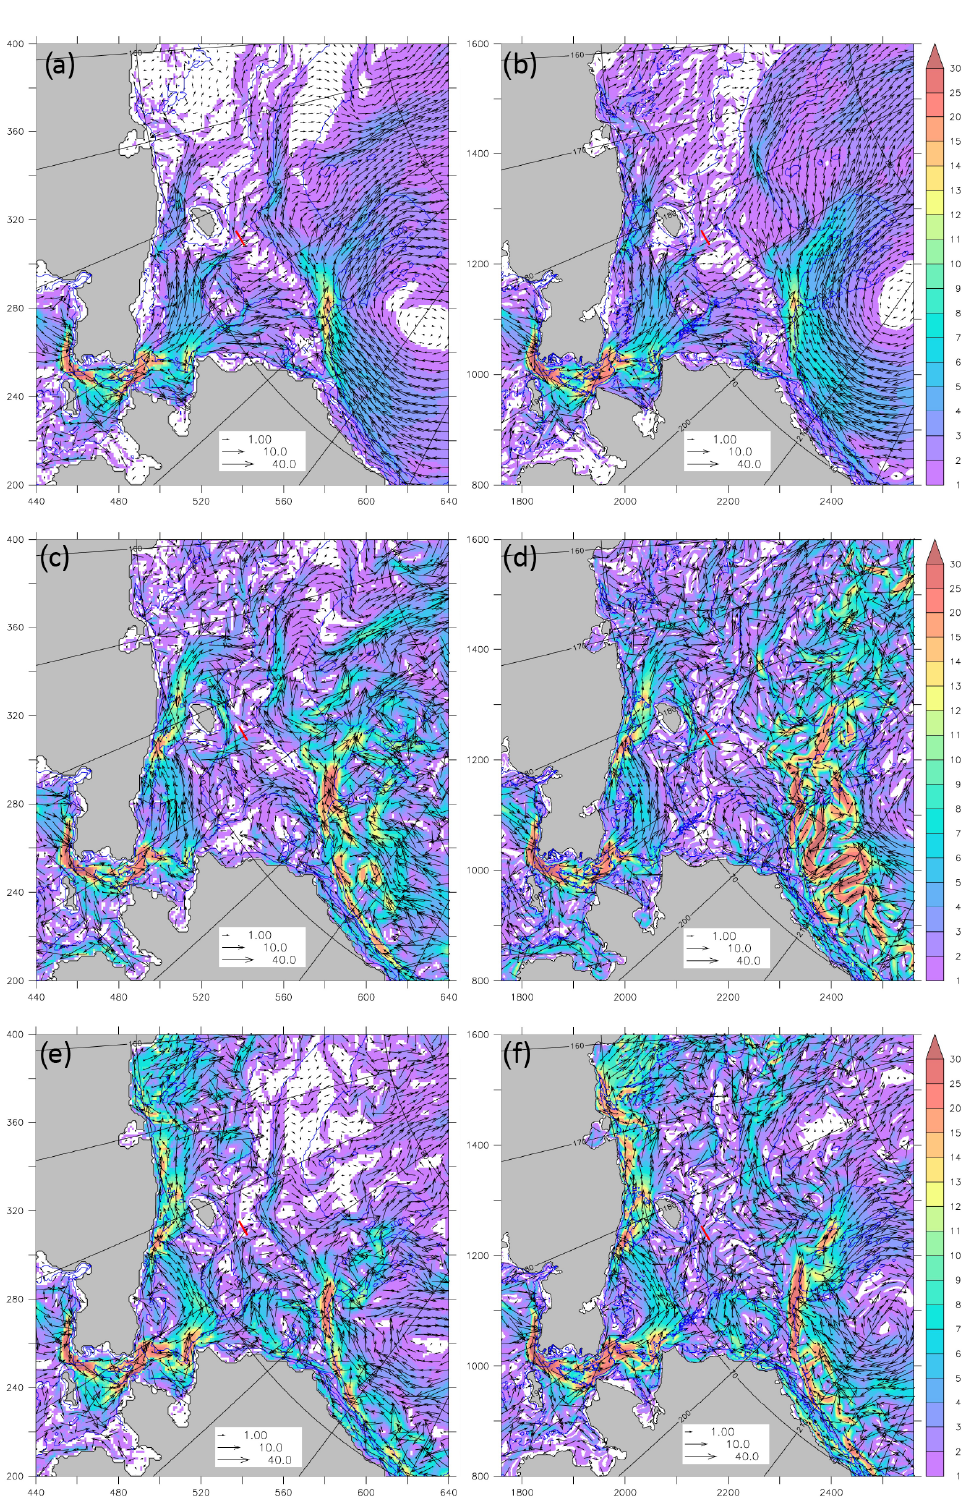
Figure 7. Upper 100m averaged speed (shading) and velocity vectors (cms − 1 ) from model output. The left column (a, c, e) is from the 9km model results and the right column (b, d, f) is from the 2km model results. The top row (a, b) is a 10-year mean from 2006–2015. The middle row (c, d) is a mean for September 2008. The bottom row (e, f) is a mean for August 2014. Every fourth vector for 9km and every 16th vector for 2km is shown. Blue lines indicate isobaths at 25, 50, 100, and 1000m. The red line indicates the location of section 3 discussed elsewhere. The x and y axes are labelled with model grid cell